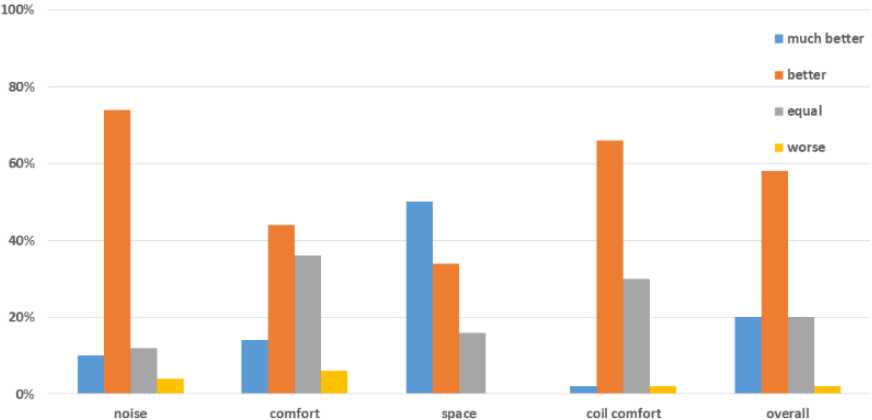
Figure 3. Overview of the patient ranking of the study at 0.55T compared to 1.5T in terms of noise level, lying comfort, coil comfort and overall sensation. level, lying comfort, coil comfort and overall sensation.